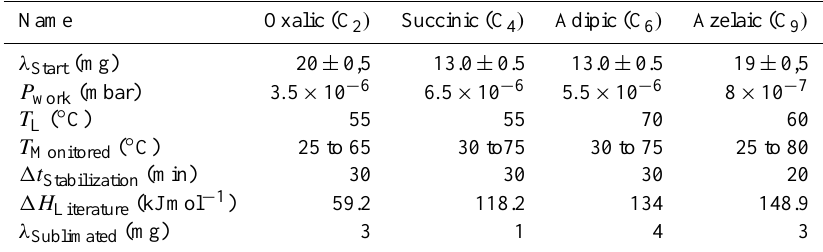
Table 2. Parameters of the experiments involving the different dicarboxylic acids. λ Start and λ Sublimated are the initial mass and the sublimated mass of the sample measured before and after the heating process with an electronic balance. Pressure is stable in the range of 10 − 6 – 10 − 7 mbar. T L is the limit temperature, i.e. the temperature above which a slope change of deposition curve is expected. T Monitored is the temperature interval where the effusion cell was heated. (cid:49)t Stabilization is the time interval where the frequency and temperature data were recorded and used for the analysis. (cid:49)H literature is the average value obtained from the values in literature (for oxalic acid, only the enthalpy of dehydrates form have been considered) which use different methods (see Table